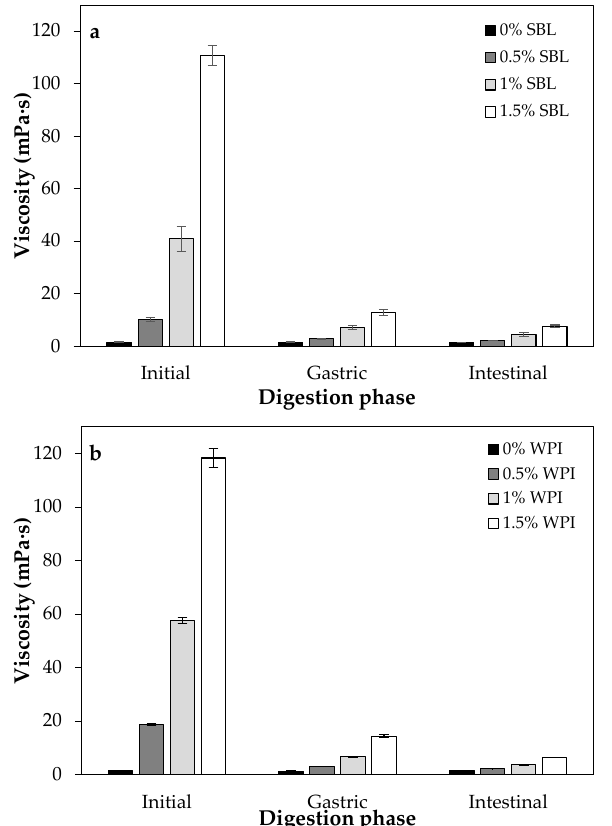
Figure 7. Viscosity of curcumin-loaded nanoemulsions stabilized with ( a ) soybean lecithin (SBL) or ( b ) whey protein isolate (WPI) and different sodium alginate concentrations (0, 0.5, 1 and 1.5%) at different phases of in vitro digestion.